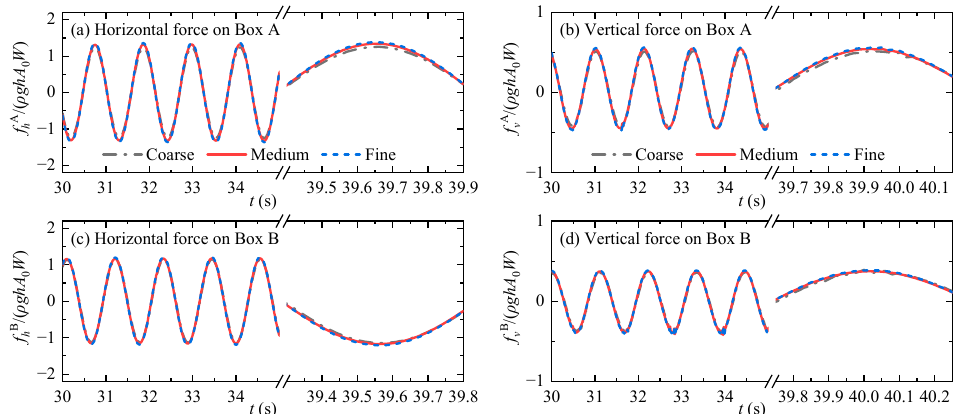
Figure 3. Mesh dependence tests for the wave forces on both boxes, in which A 0 = H 0 /2 denotes the amplitude of the incident